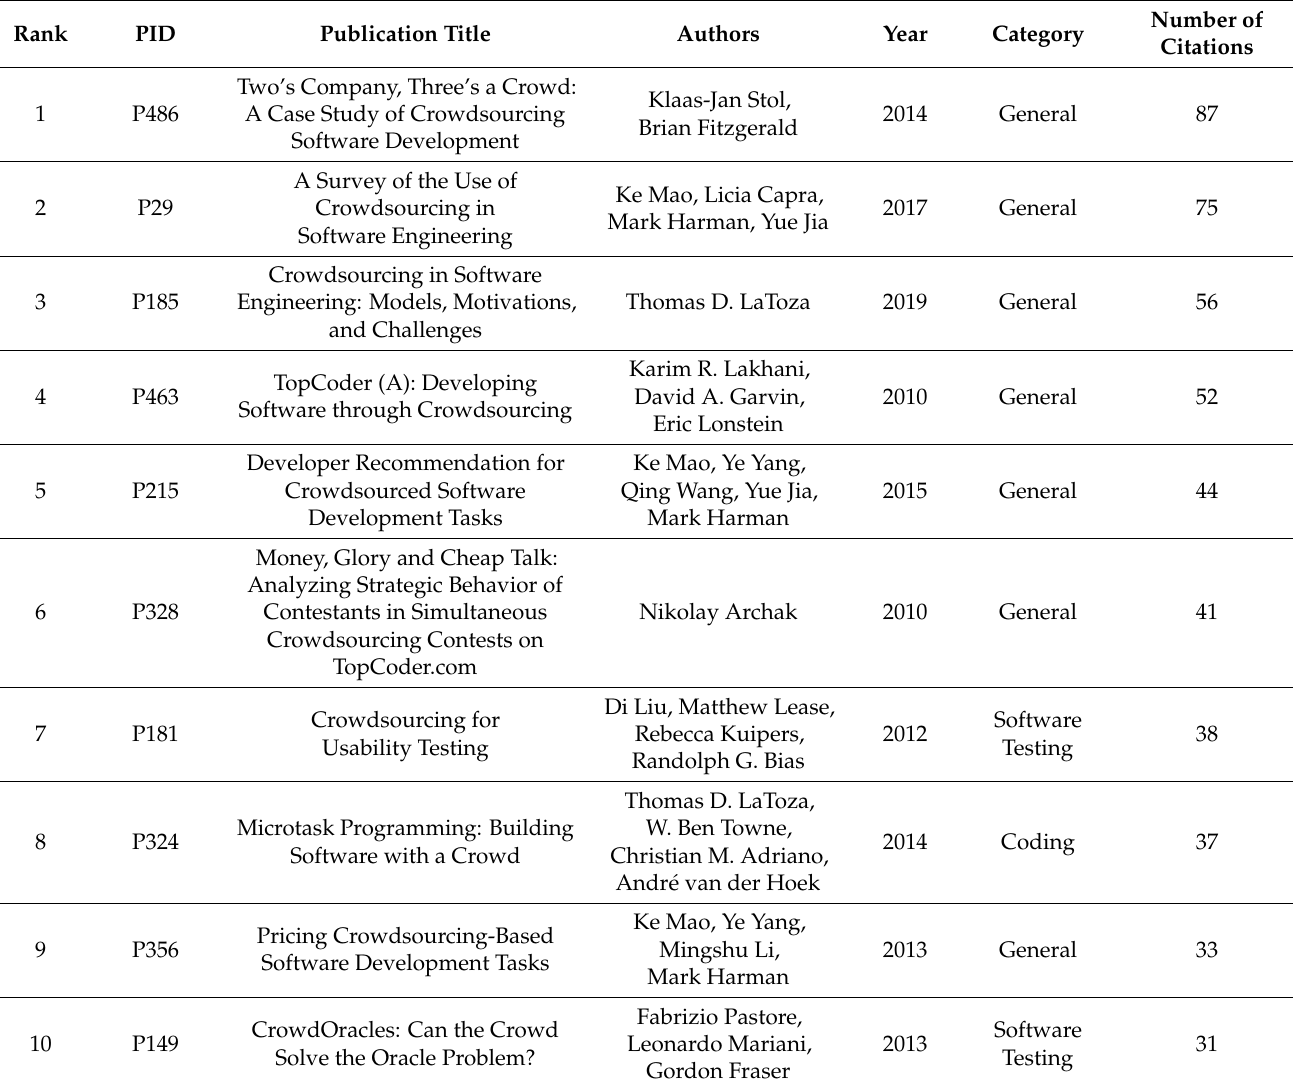
Table 15. The 10 most frequently cited CSE